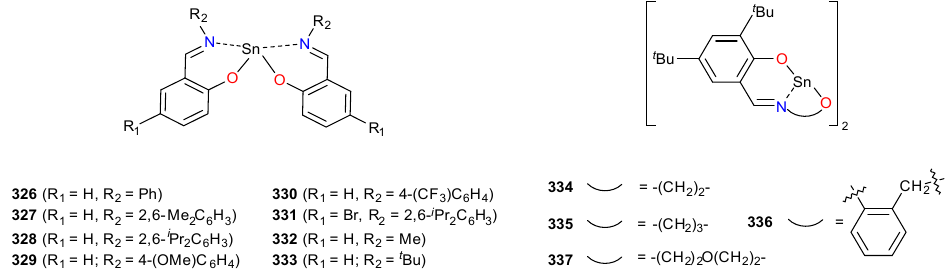
Figure 54. Schiff-based Sn II complexes active in the ROP of ε -CL and lactides [148,149].